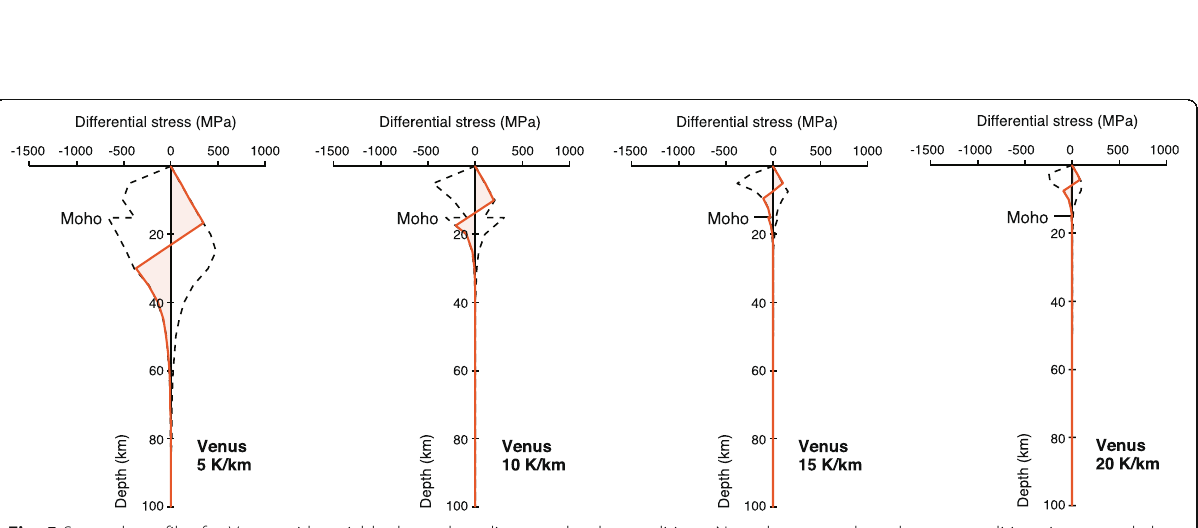
Fig. 5 Strength profiles for Venus with variable thermal gradients under dry conditions. Note that strength under wet conditions is extremely low and that the mechanical thickness is expected to be less than 1 km. Calculation parameters are the same as those for Fig.